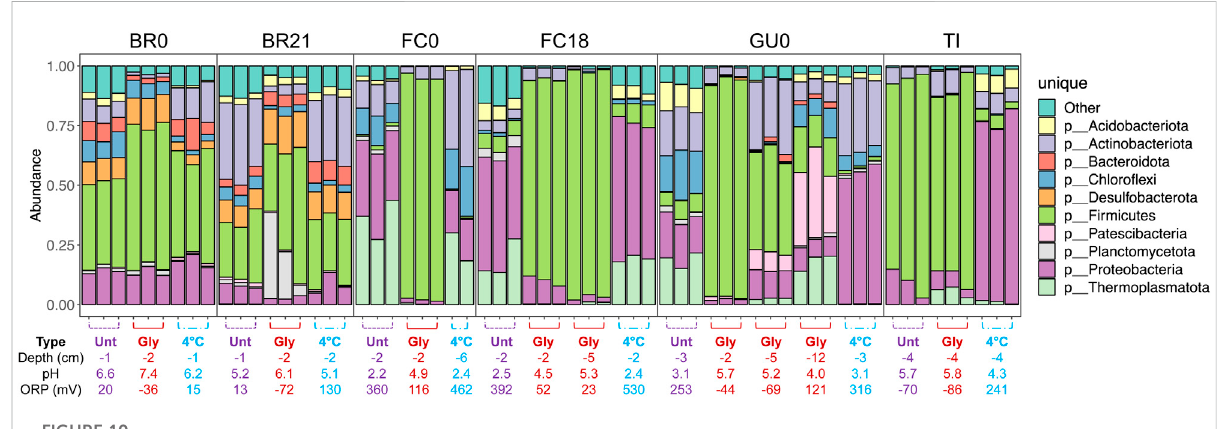
FIGURE 10 Relativeabundanceof16SrRNAgeneampliconsequencereadsassignedtothe10mostabundantphyla.Foreachtriplicatedsamplethedepth, pH and ORP are given below.